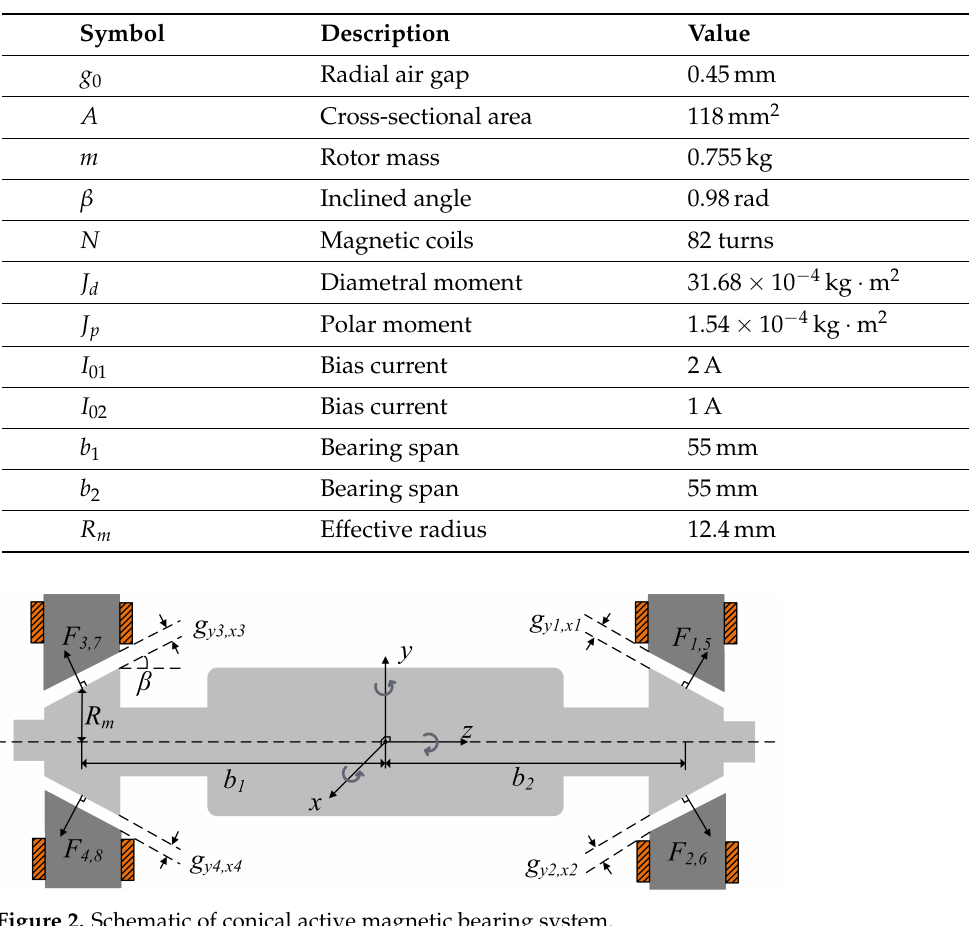
Table 1. System parameters.